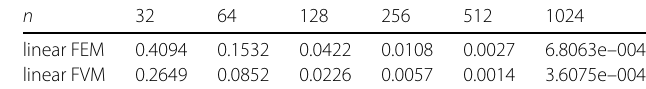
Table 11 The error in the relative discrete H 1 -seminorm for problem (5.2) with k = 30 n 32